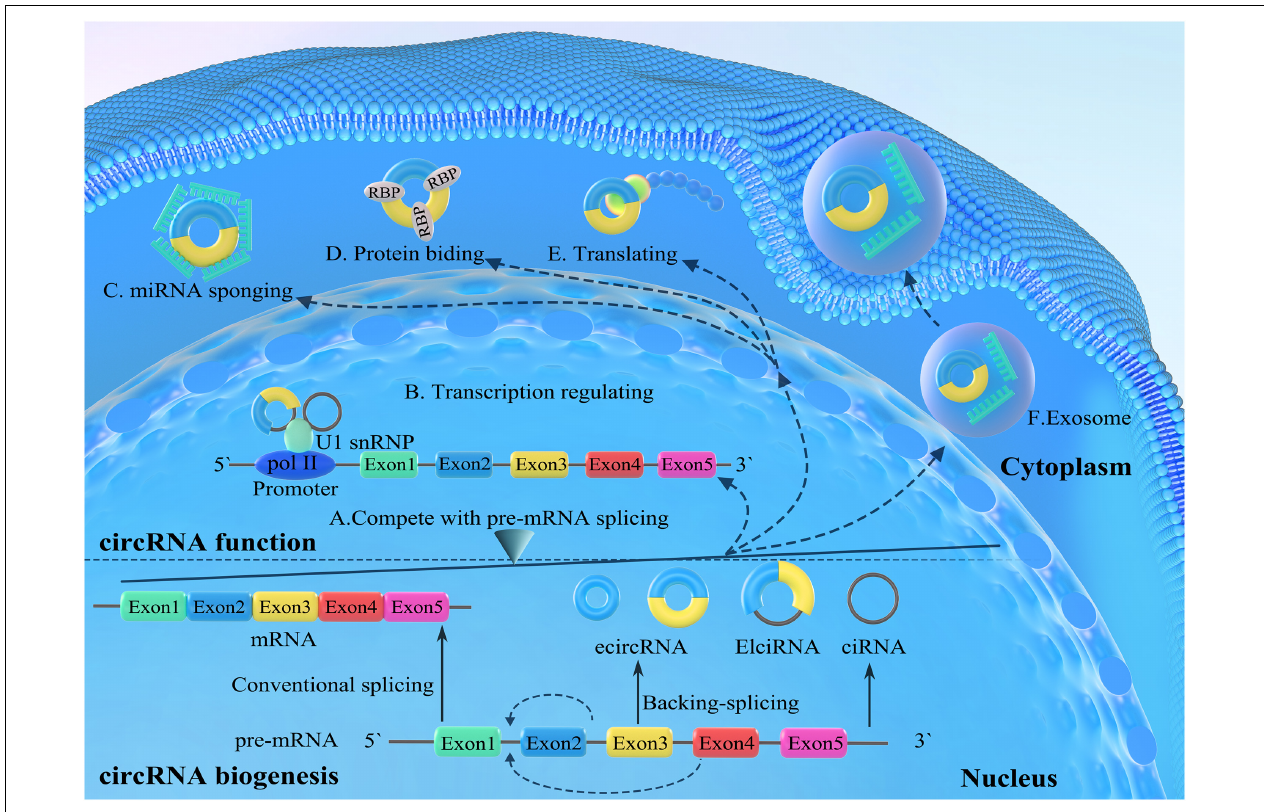
FIGURE 1 | Biogenesis and functions of circular RNAs (circRNAs). The canonical splicing excludes the introns from immature pre-messenger RNA (pre-mRNA) to generate mature mRNAs. CircRNAs are derived from the unique back-splicing that covalently attaches the 3 (cid:48) splice acceptor to the downstream 5 (cid:48) splice donor, forming closed-loop structures, including exonic circRNAs (ecircRNAs), exon-intron circRNAs (eicircRNAs), and intronic circRNAs (ciRNAs). Generation of circRNAs competes with pre-mRNA splicing. CircRNAs regulate the transcription and splicing of parental genes by interacting with RNA polymerase II or transcription-related factors. CircRNAs competitively bind miRNAs and serve as intracellular competitive endogenous RNAs (ceRNAs), eliminating the suppressive effect of miRNAs on target genes. CircRNAs can also interact with RNA-binding proteins (RBPs) and serve as protein baits or antagonists, thus inhibiting the function of proteins. Some circRNAs are able to be translated into proteins. In addition, circRNAs can be transported into the extracellular space and adjacent cells or body fluids for regulation